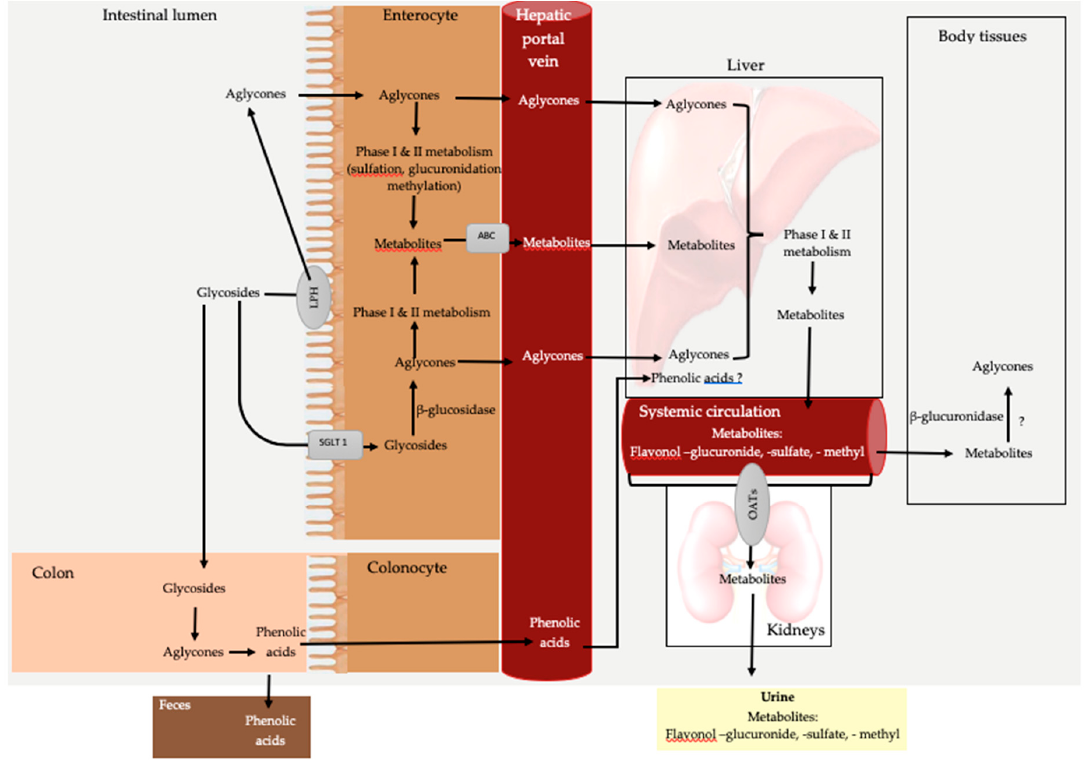
Figure 2. General overview of dietary flavonol bioavailability. Abbreviations: LPH, lactase-phlorizin hydrolase enzyme; SGLT 1, sodium-dependent glucose transporter; ? = mechanism is not well understood.